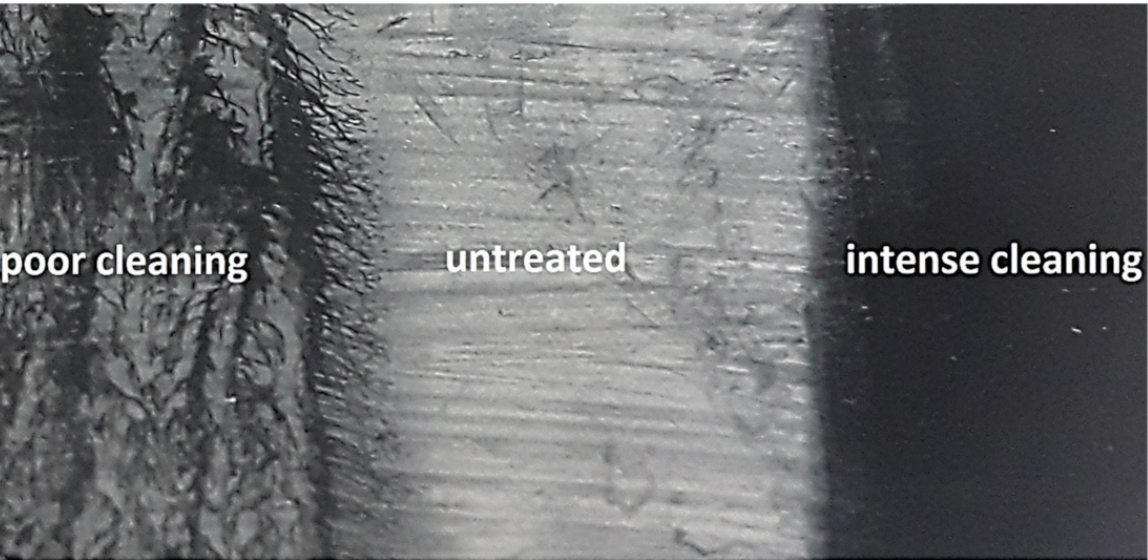
Figure 8. Different cleaning results. From left to right: poor cleaning, untreated reference area, and intense